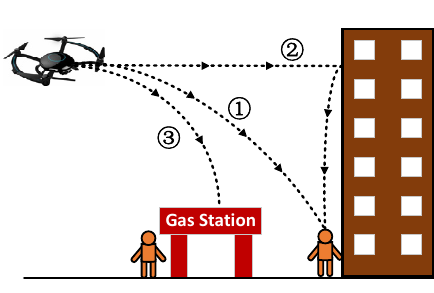
Figure 2. Potential hazard events. ① is the ballistic descent; ② is the obstacle collision; ③ is the secondary damage.